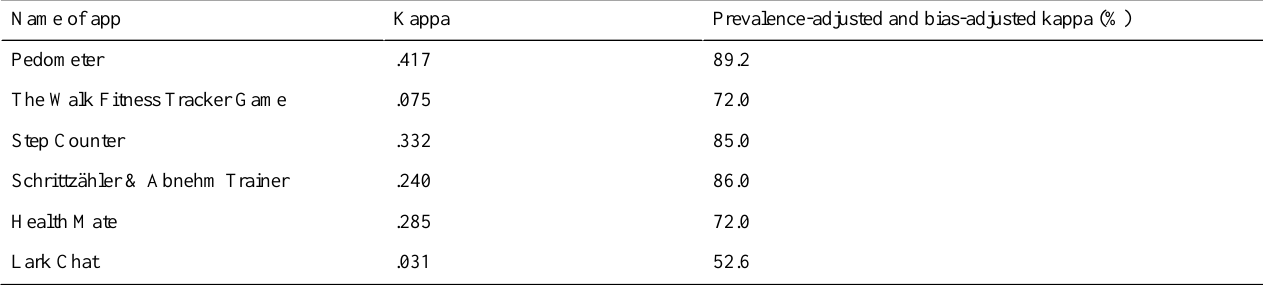
Table 2. Interrater reliability